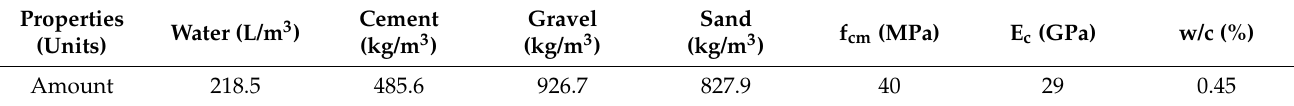
Table 1. The Arosa structure’s concrete mixtures and mechanical